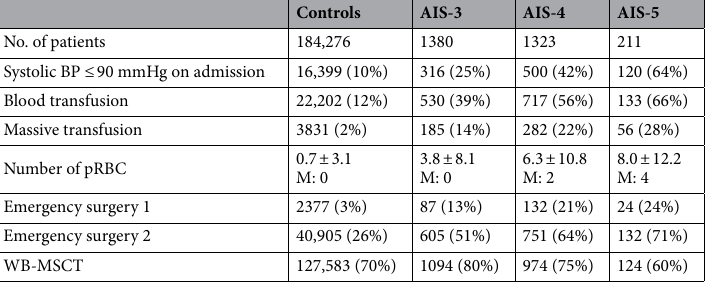
Table 3. Early clinical management in subgroups according to severity of abdominal vascular trauma. Total numbers and percentages of each group are given with the total number of available datasets for each characteristic in parenthesis. Total patient numbers may vary for each procedure and characteristic because of incomplete data transmission or transmission of basic datasets. Basic datasets do not include information on emergency/early surgery. Massive transfusion: ≥ 10 units of packed red blood cells. Emergency surgery 1: immediate surgery requiring cessation of the implemented trauma resuscitation algorithm (2002 until 2015); Emergency surgery 2: Intervention (since 2009, from a list of 7 critical interventions, in the ER or directly consecutive). BP blood pressure, pRBC packed red blood cells, M median, WB-MSCT whole-body multi-slice computed tomography.